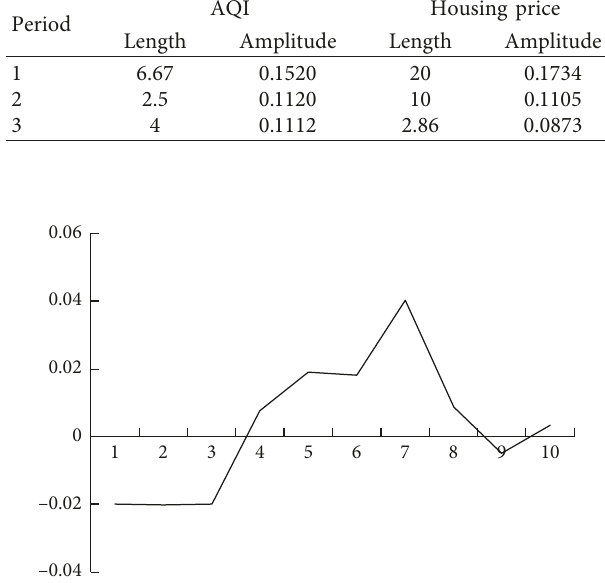
Figure 6: Grey association spectrum analysis of AQI and housing